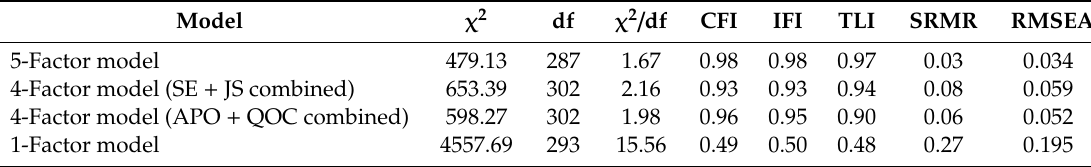
Table 4. Confirmatory Factor Analysis